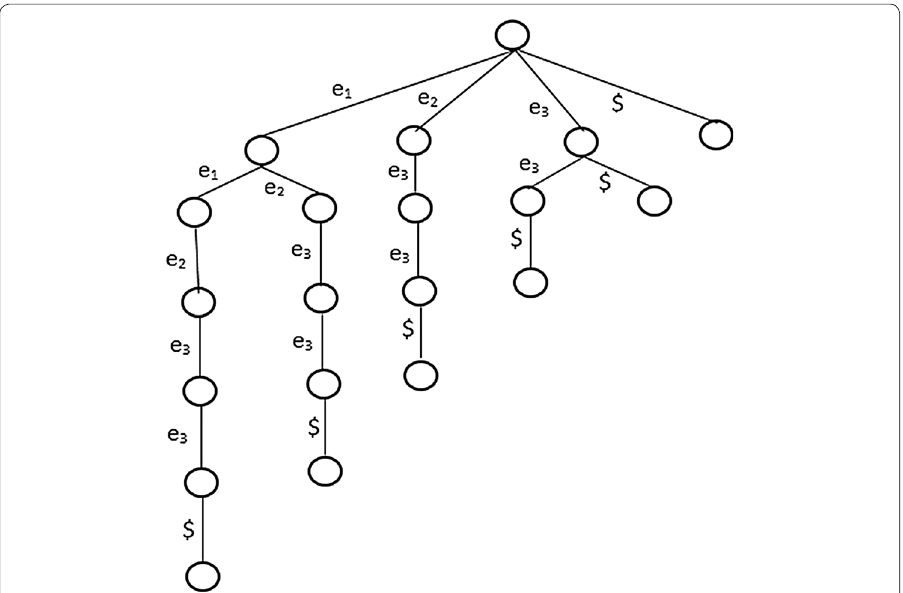
Fig. 3 Suffix tree of string e1, e1, e2, e3, e3,